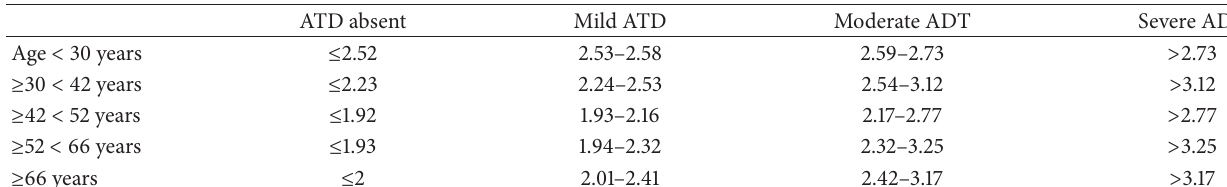
Table 1: Age-stratified cut-off points of VAI for identification of adipose tissue dysfunction (ATD).